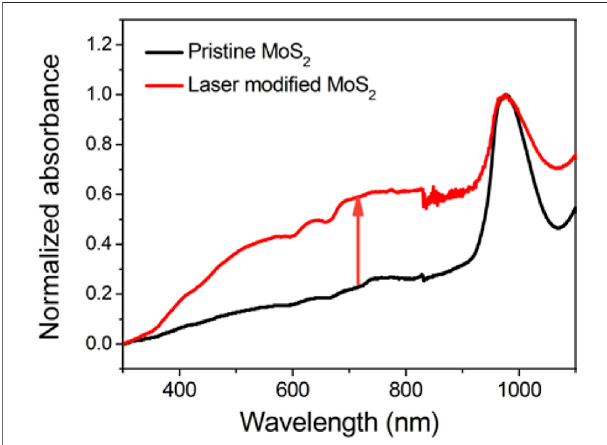
FIGURE 3 | Absorption spectra of pristine MoS MoS 2 .